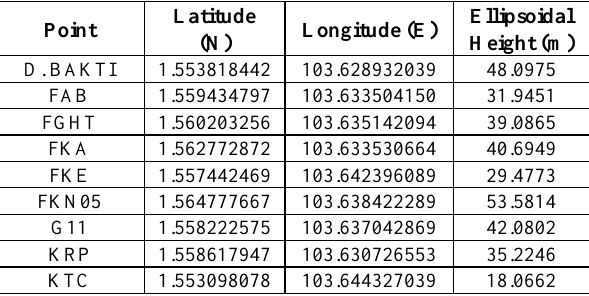
Figure 7. Gravimetric Geoid of MyGeoid in UTM